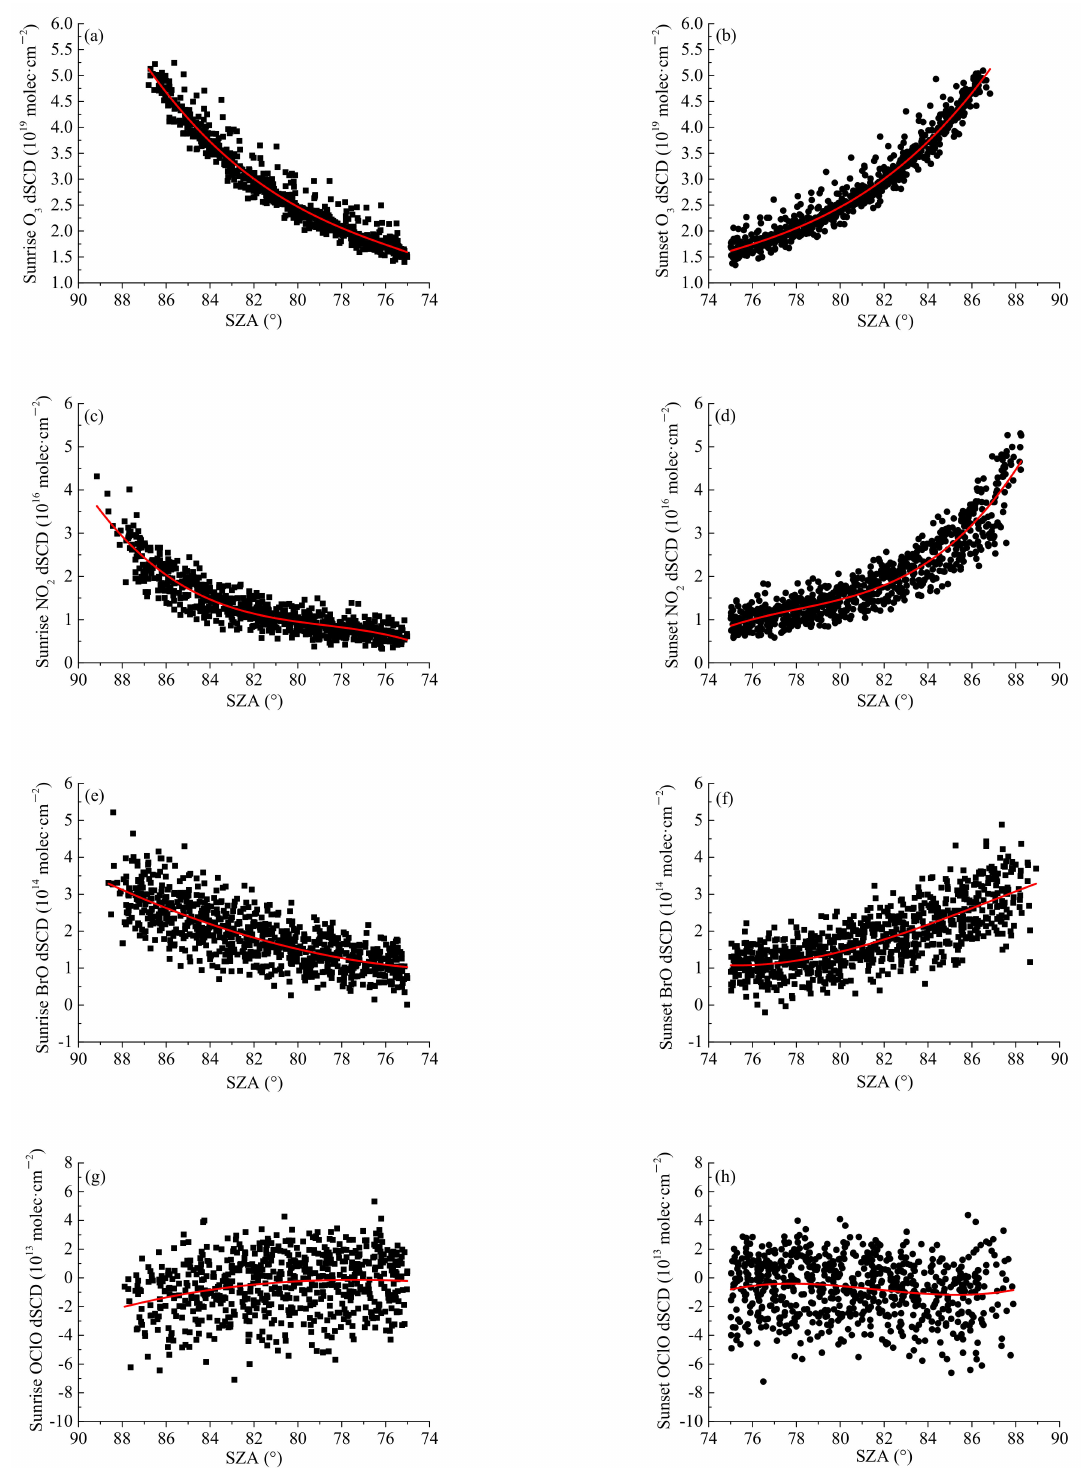
Figure 4. Variations of the retrieved ( a , b ) O 3 , ( c , d ) NO 2 , ( e , f ) BrO, and ( g , h ) OClO dSCDs with SZA for sunrise (left column) and sunset (right column) during the effective observation period. Third-order polynomials are fitted to the retrieved dSCDs (red